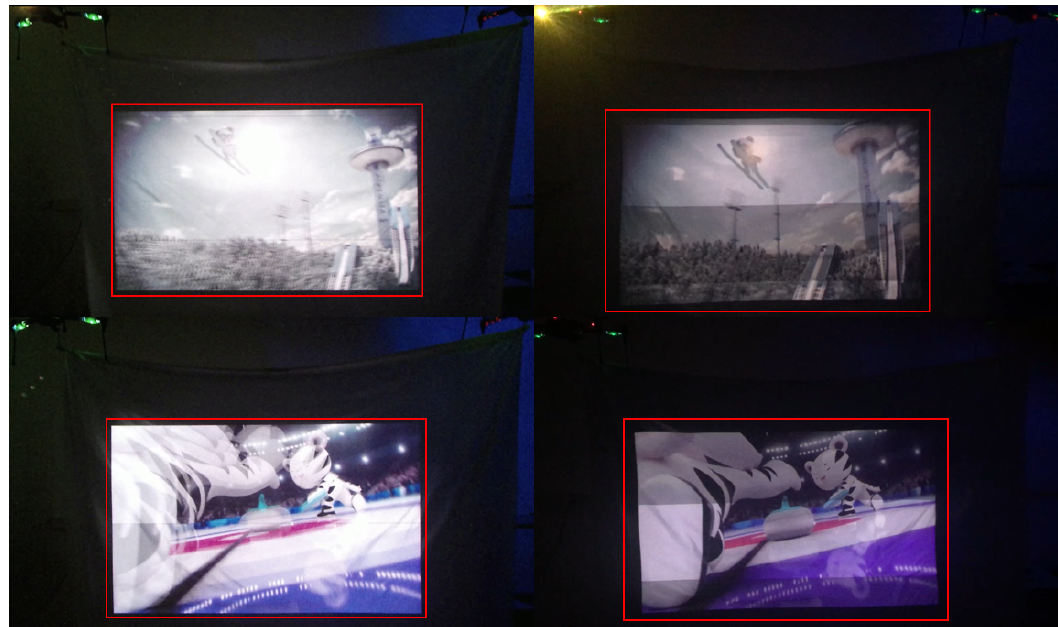
Figure 11. DIW results from dynamic non-planar surfaces generated from UAVs and a lightweight canvas. The left column depicts the result obtained with the proposed method and the right column shows the output of a conventional